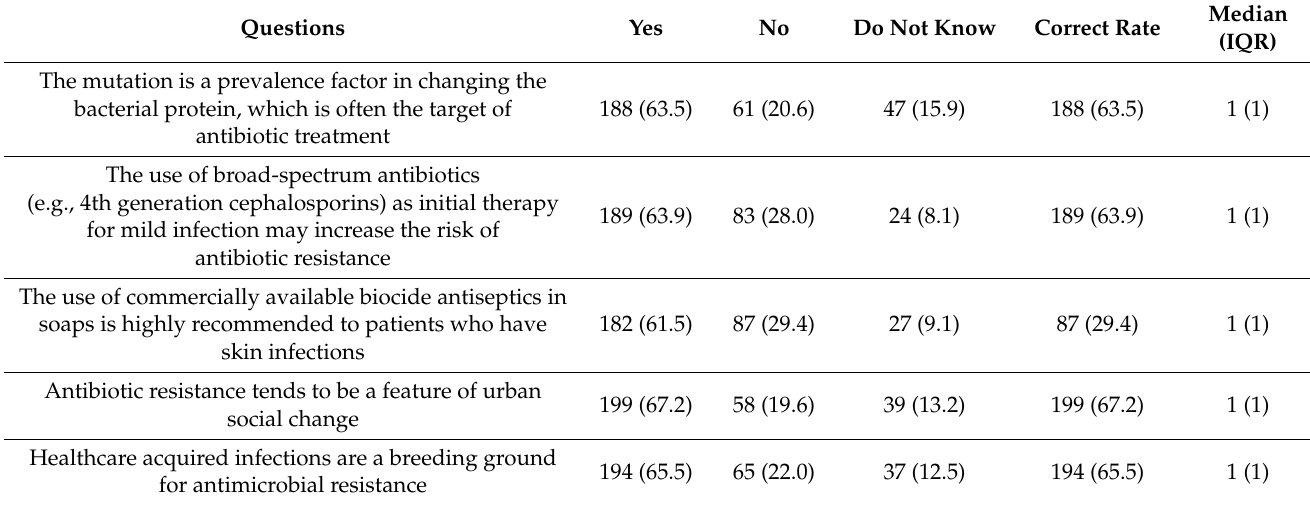
Table 5. Understanding about factors contributing to antibiotic use n (%).